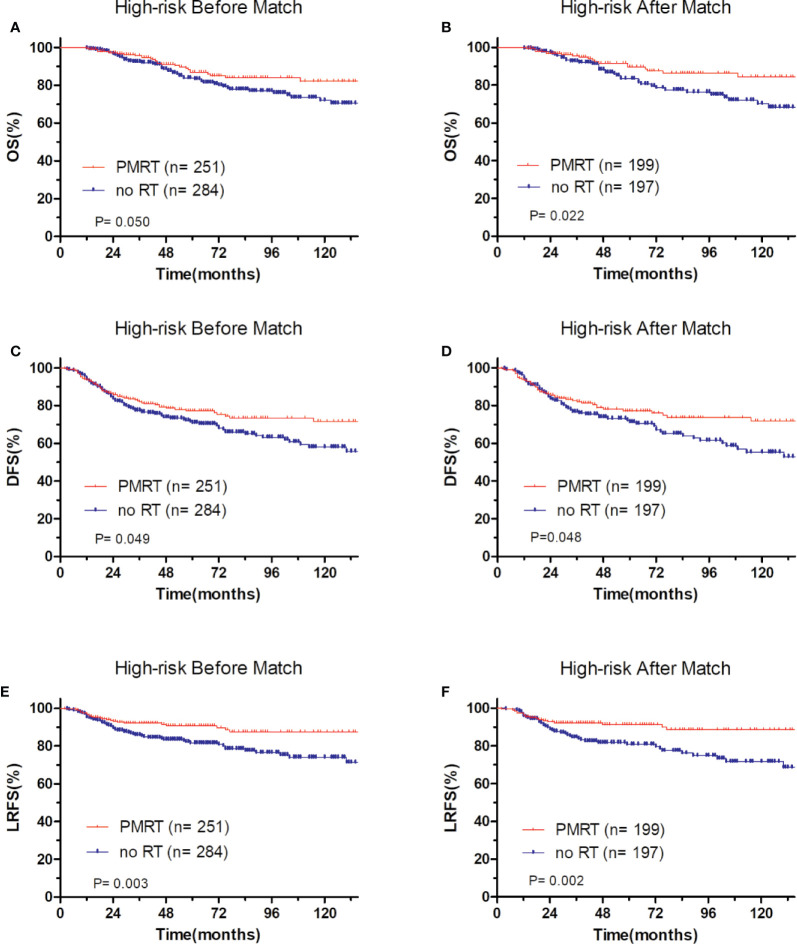
Comparison of OS and DFS and LRFS between with PMRT and without PMRT for high-risk pT1-2N1M0 patients. For patients with PMRT or without PMRT, OS before (A) and after (B) match stratification; DFS before (C) and after (D) match stratification; LRFS before (E) and after (F) match stratification.